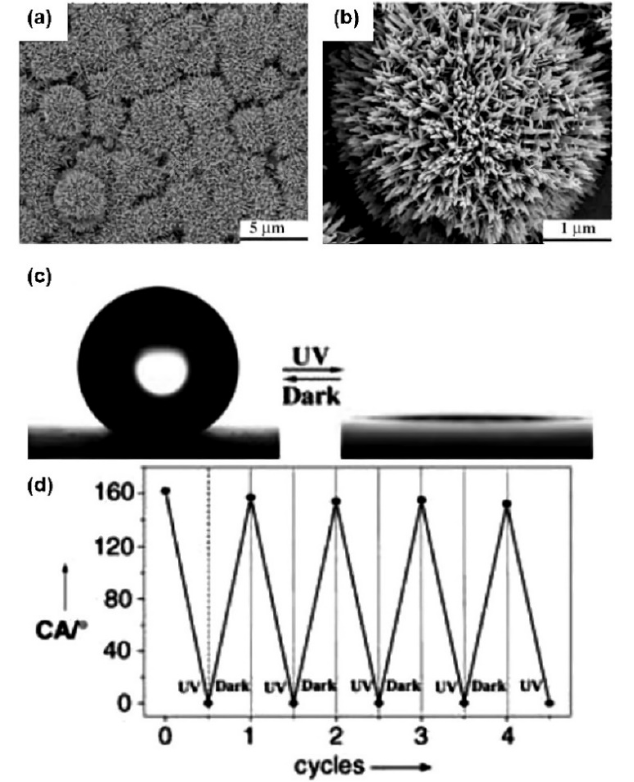
Figure 3. Switchable wettability of a TiO 2 nanorod under UV light and storage in dark. ( a ) Low- magnification FE-SEM image of a TiO 2 nanorod film deposited on a glass wafer; ( b ) Morphology of a single papilla at high magnification; ( c ) Photographs of a water droplet changing during UV- illumination and storage in dark; ( d ) Reversible superhydrophilic–superhydrophobic transition of the TiO 2 films by UV and storage in dark. Reprint from [66]. Copyright (2005), with permission from WILEY-VCH, Weinheim,